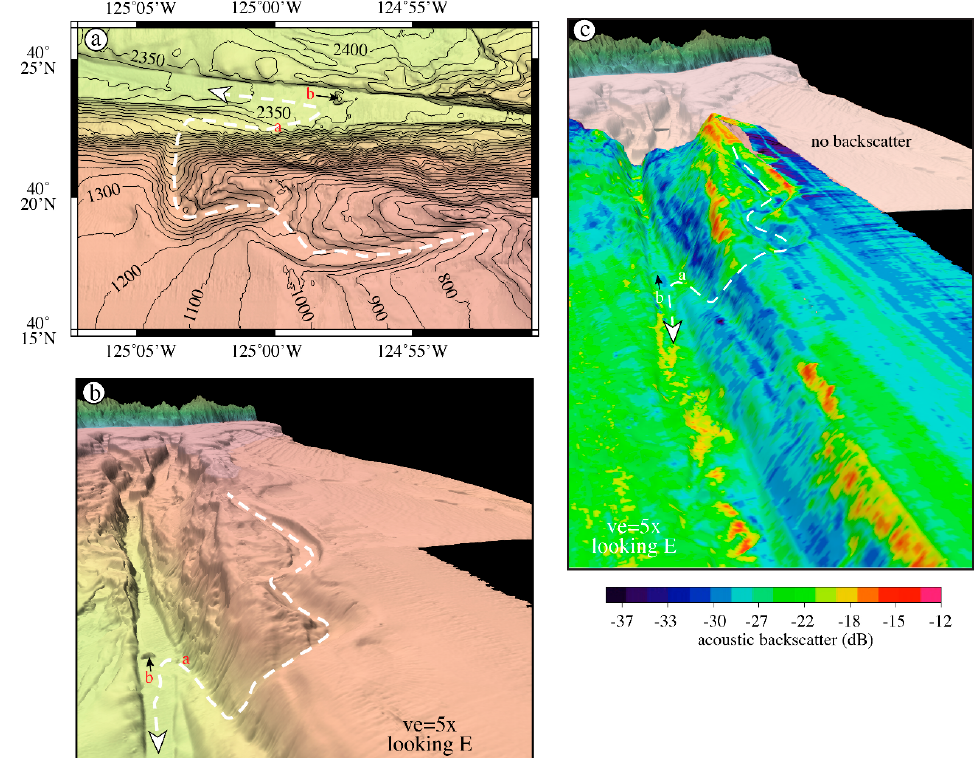
Figure 9. ( a ) Map view of multibeam bathymetry of upper side channel. White dashed line and arrowhead traces the thalweg of the upper side channel. Red “b” points to large mound on upper straight reach (USR) floor. Isobaths of Gorda Escarpment intentionally left unlabeled; ( b ) Perspective view with 5× vertical exaggeration of multibeam bathymetry of the upper side channel, north wall of Gorda Escarpment, and the floor of upper straight reach. Red “b” points to large mound on USR floor; ( c ) Perspective view of multibeam acoustic backscatter draped on the multibeam echosounder (MBES) bathymetry of upper side channel (white dashed line and arrowhead), the north wall of Gorda Escarpment, floor of upper straight and upper sinuous reaches and adjacent levee. White “a” is entry point of upper side channel to Mendocino Channel, white “b” points to large mound on USR floor. Note the high backscatter (red and yellow colors) in Mendocino Channel floor that begins where the upper side channel enters the Mendocino Channel floor and continues down-channel.